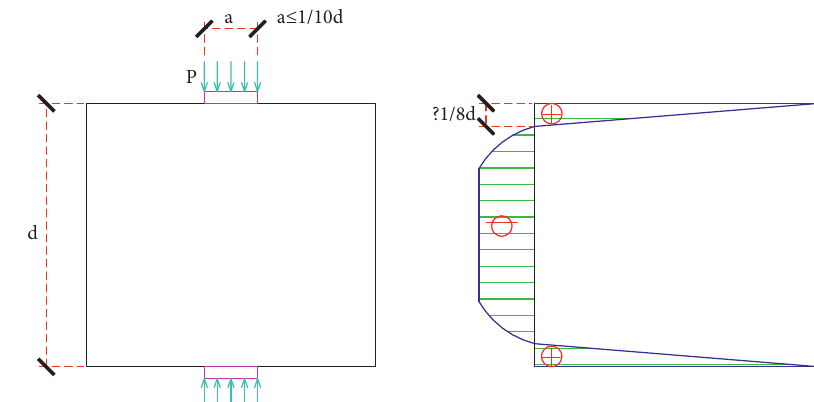
Figure 9: Schematic diagram of vertical lateral stress distribution of the split